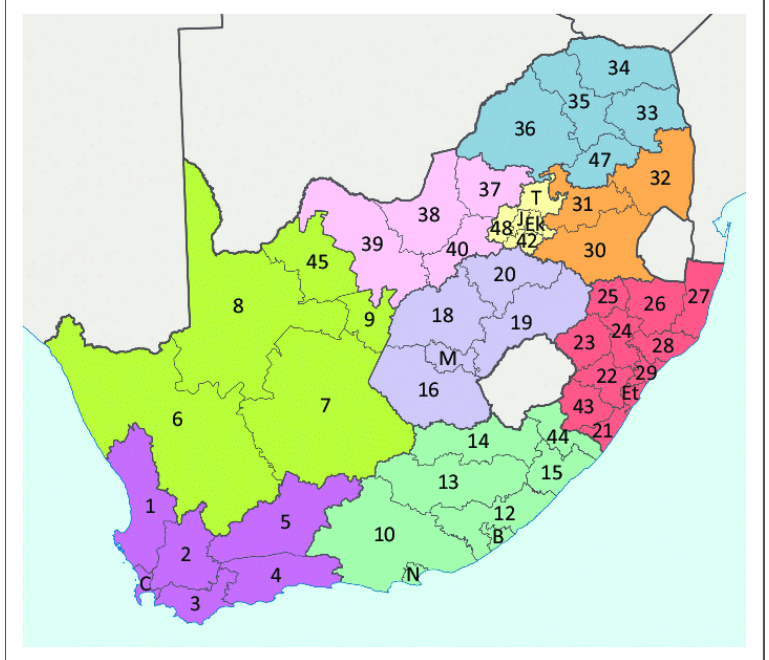
Figure 1. The distribution of study sites by provinces in South Africa. Source: Brinley. The area in pink colour covering 37–40 is North West province. The area covered by numbers 33–36 and 47 is Limpopo province. The number represent the district municipalities. DRKK, denoted by 40, Capricorn is 35 and Vhembe is